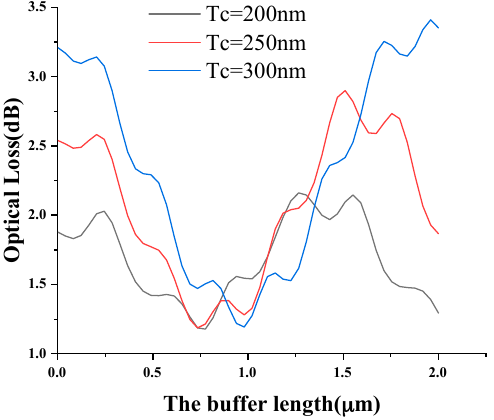
Figure 4. The optical loss in the air with the buffer length for different OWC thicknesses.